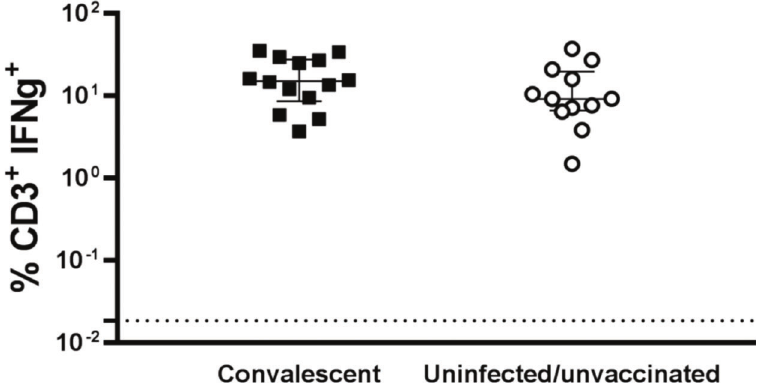
Figure S2 - T cell responses to PMA/ionomycin. PBMCs from convalescent COVID-19 individuals (black squares) (n=14) and uninfected/ unvaccinated donors (white circles) (n=12) were incubated for the last 6h with PMA (30 ng/mL) and ionomycin (0.3 m g/mL) (positive control). The logarithmic scale represents the percentage of T cells producing IFN- g . Scatterplots show lines at the median with interquartile ranges. The dashed line represents the assay cut-off value of 0.001%. IFN- g expression by CD3 + T cells was analyzed by intracellular flow cytometry. T-tests and nonparametric Mann-Whitney tests were used to calculate p values. No significant differences in IFN- g production were observed between groups ( p